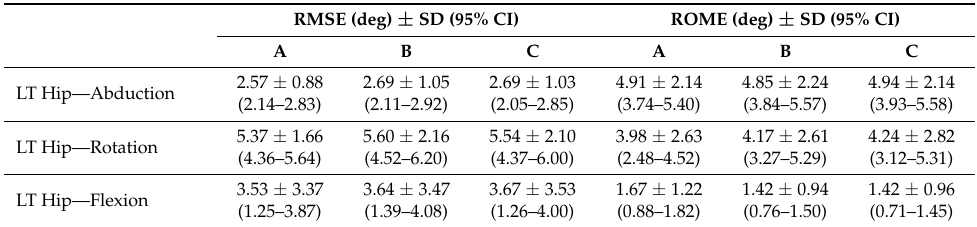
Table 2. Mean RMSE and ROME of condition 2 over all subjects ± SD; brackets contain 95% CI. A, B, C indicate beginning, middle and end of the 6 min walk test.